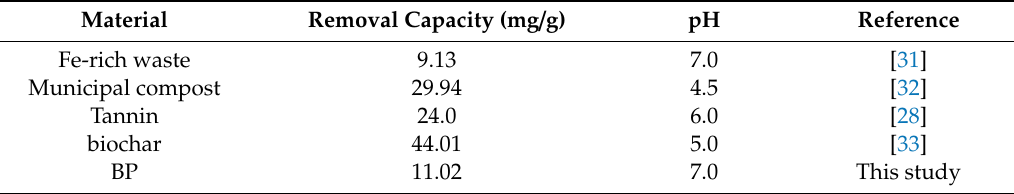
Table 4. The maximum adsorption capacity of antimony using